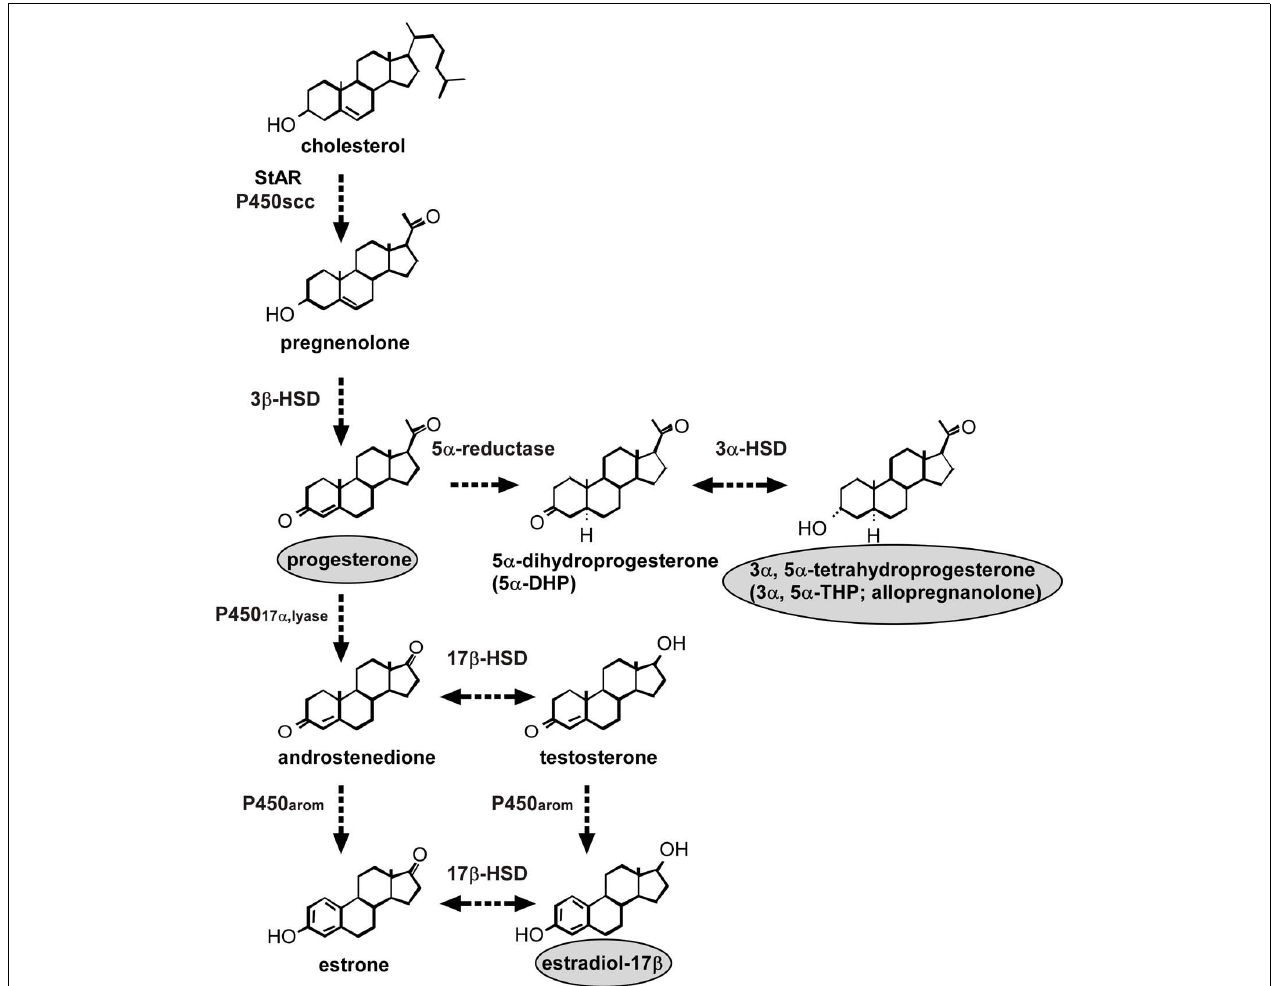
Estrogen formation in the Purkinje cell also occurs in the neonate because this neuron further expresses P450 17 α ,lyase and P450arom. See the text for details. StAR, steroidogenic acute regulatory protein; P450scc, cytochrome P450 side-chain cleavage enzyme; 3 β -HSD, 3 β -hydroxysteroid dehydrogenase/ Δ 5 - Δ 4 -isomerase; P450 17 α ,lyase , cytochrome P450 17 α - hydroxylase/c17,20-lyase; 17 β -HSD, 17 β -hydroxysteroid dehydrogenase; 3 α -HSD, 3 α -hydroxysteroid dehydrogenase; P450arom, cytochrome P450